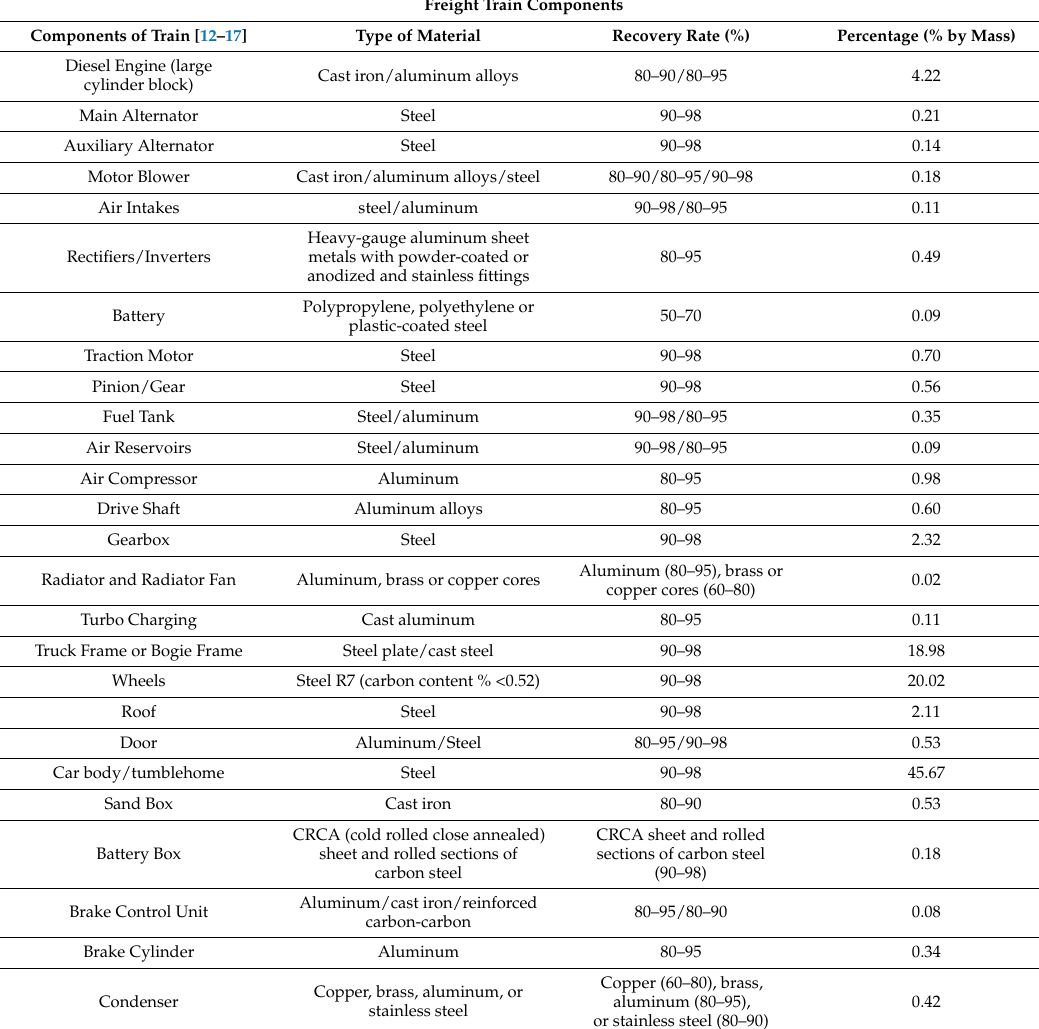
Table 1. Component analysis of freight trains. Some component weights are available from the industry sources. All data has been taken from the parts manufacturers’ documents available on Union des Industries Ferroviaires Europ é ennes (UNIFE) and train companies’